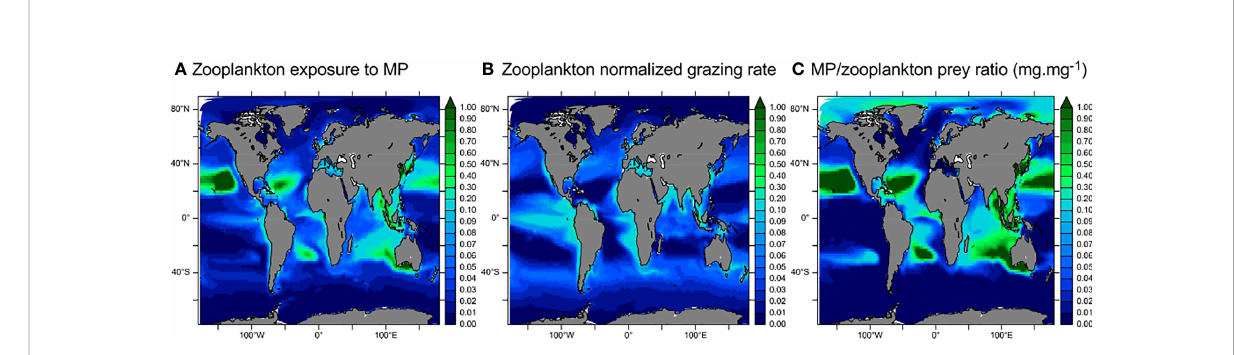
FIGURE 6 Maps of zooplankton exposure to MP ingestion and its driving factors (averaged in the fi rst 100 m). (A) Zooplankton exposure to MP ingestion (unitless, see Methods ). (B) Modelled normalized zooplankton grazing. (C) Modeled MP/prey ratio (as per Equation